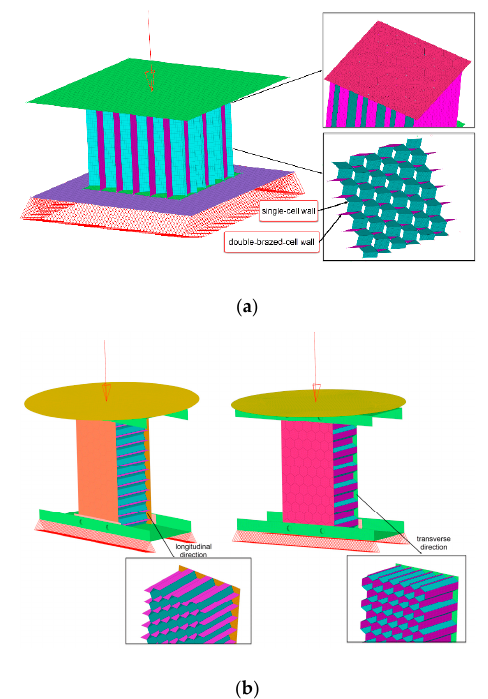
Figure 6. ( a ) Finite element model under out-of-plane compression; ( b ) Finite element model under in-plane compression in transverse and longitudinal directions.